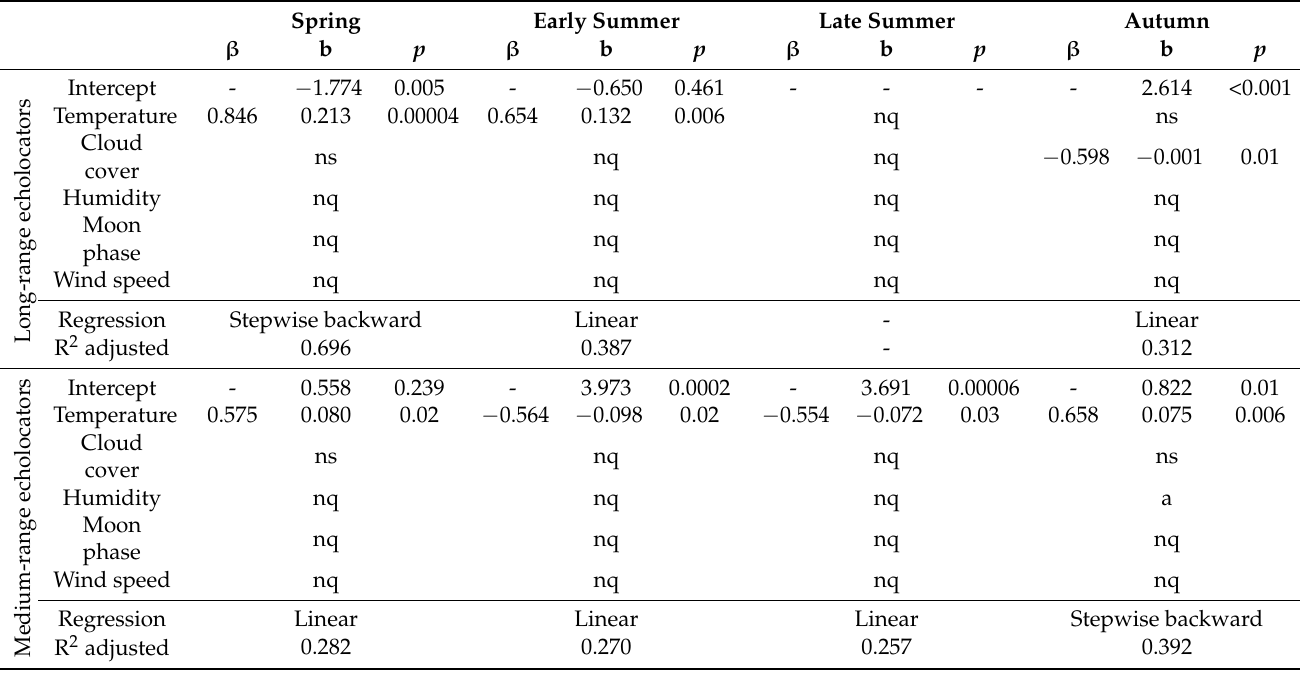
Figure 3. Seasonal differences in the activity of ( a ) long-range echolocators (LRE) and ( b ) medium-range echolocators (MRE). Abbreviated seasons’ names are as follows: S—spring, Es—early summer, Ls—late summer, A—autumn. Identical letters or lack of letters above boxplots indicate a lack of significant differences between seasons. Table 2. Results of applied models of regression to determine the impact of weather predictors on an activity of long-range echolocators group ( Nyctalus , Eptesicus and Vespertilio genera) and on medium-range echolocators group ( Pipistrellus and Hypsugo genera) within each analyzed season (detailed description in